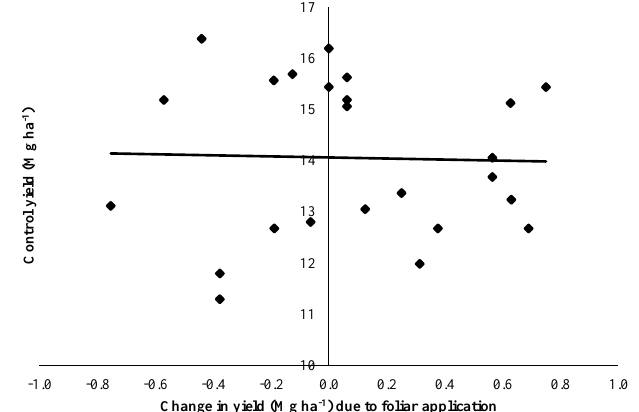
Figure 7. Relationship between the control maize grain yield and the grain yield response to foliar micronutrient application for 26 sites. Our hypothesis was that higher yielding sites would have a greater yield response but this relationship did not occur (r = 0.03 ).